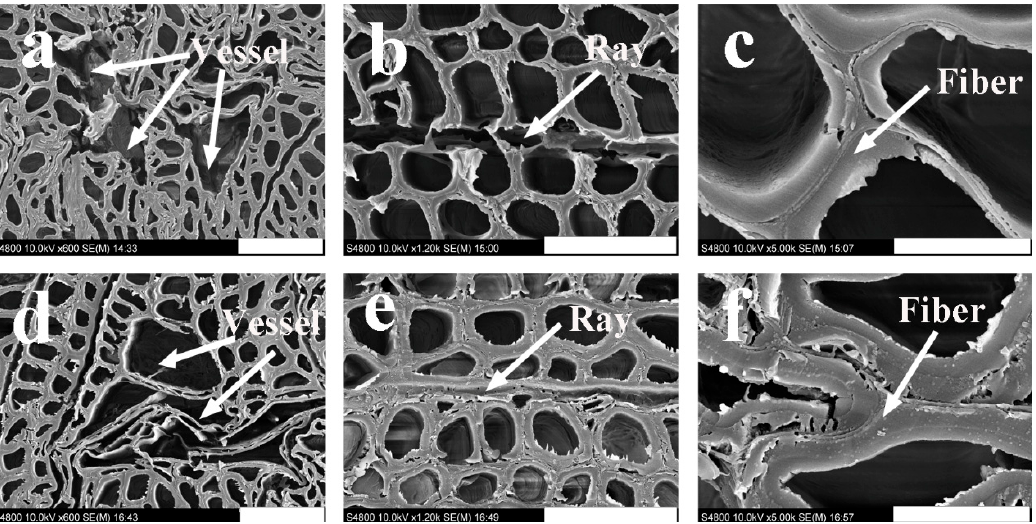
Figure 9. Scanning electron microscope (SEM) images of OWMEC with different resin contents after 12 weeks of incubation with T. versicolor fungi. ( a – c ): 8% resin content; ( d – f ): 18% resin content. Scale bars: ( a , d ): 50 µm; ( b , e ): 40 µm; ( c , f ): 10 µm.